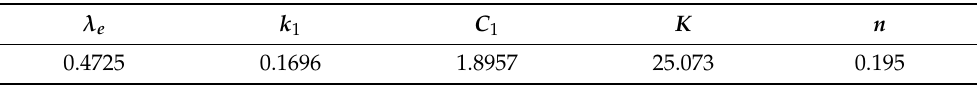
Table 2. Fitted parameters of the second-order thixotropic model based on Equation (8). λ